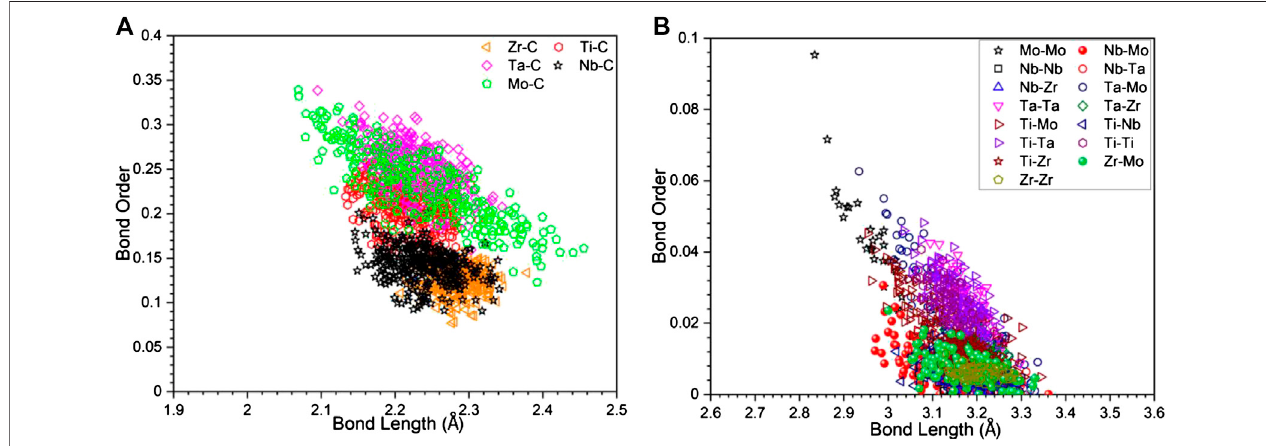
FIGURE 4 | The scatter plot of bond order vs. bond length of (A) transition metal with carbon, and (B) transition metal components with itself.